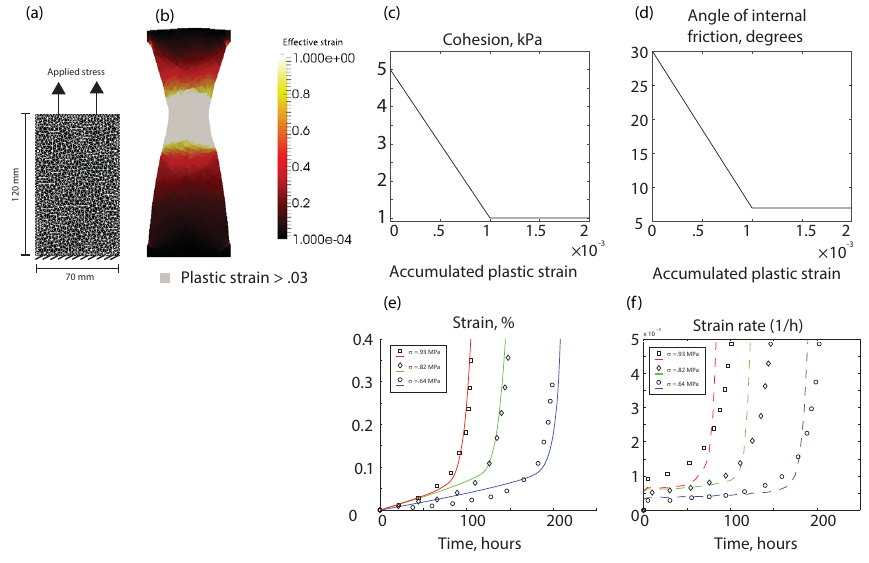
Figure A1. Calibration experiments for semi-brittle ice based on laboratory-derived data presented in Mahrenholtz and Wu (1992). (a) Initial mesh and dimensions and (b) effective strain after failure of semi-brittle ice with 0.82MPa applied vertical stress. Overlaid on top is the accumulated plastic strain (grey) of elements > 0.03. Because the grey extends horizontally throughout the ice plug, we consider an accumu- lated plastic strain of 0.03 or greater to represent ruptured ice. (c) Cohesion and (d) angle of internal friction parameters that are needed as a function of accumulated plastic strain to reproduce the (e) strain- and (f) strain-rate-vs.-time curves presented in Mahrenholtz and Wu (1992). Open black points are laboratory-derived data, and colored lines are from DES